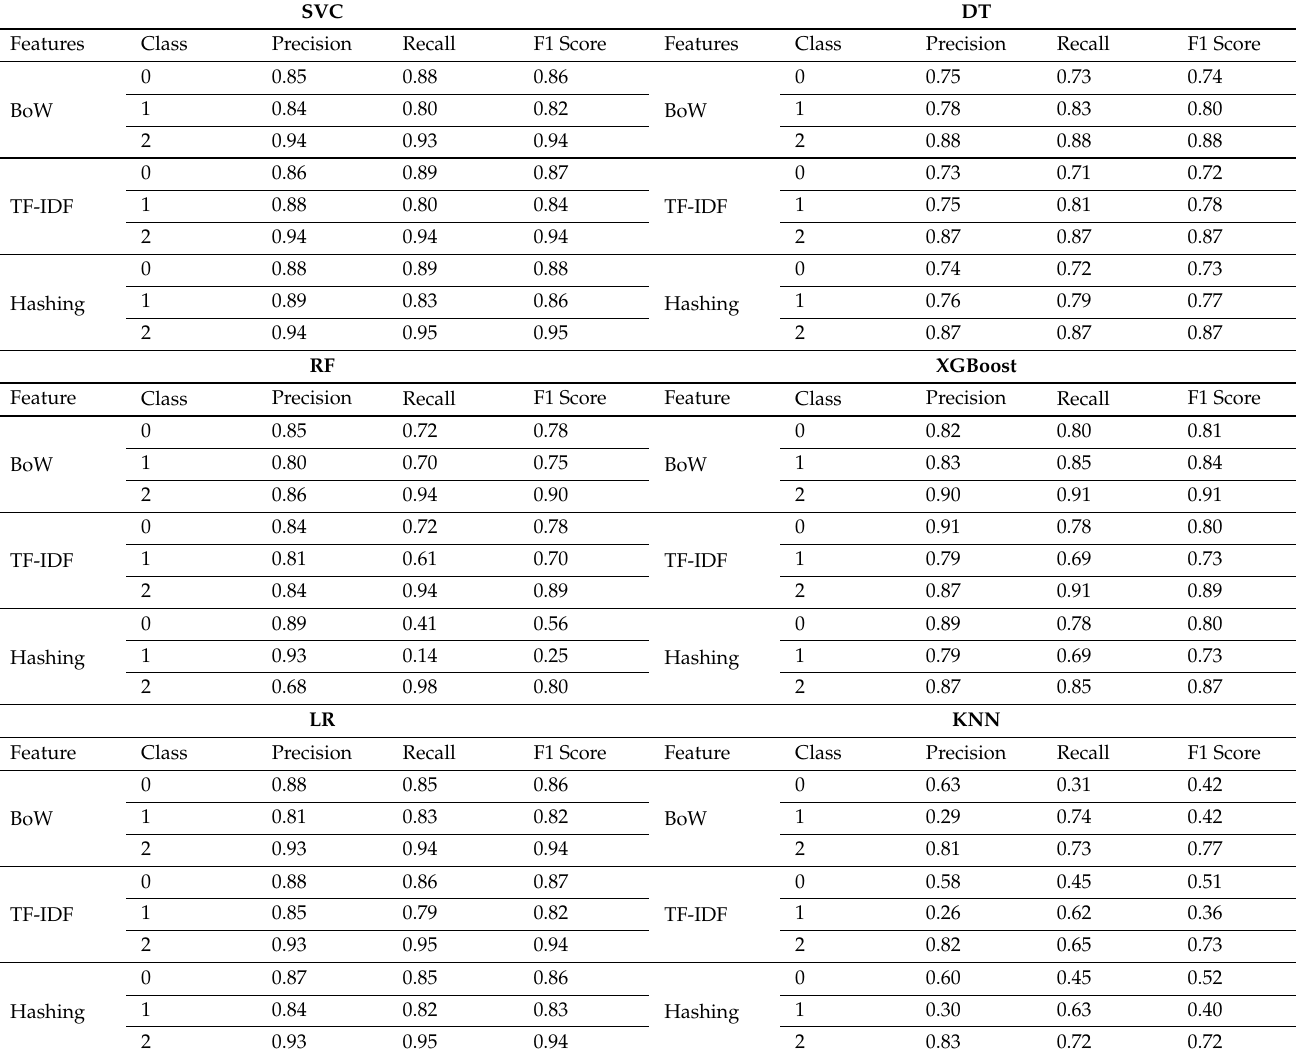
Table 15. The per class scores for the machine-learning